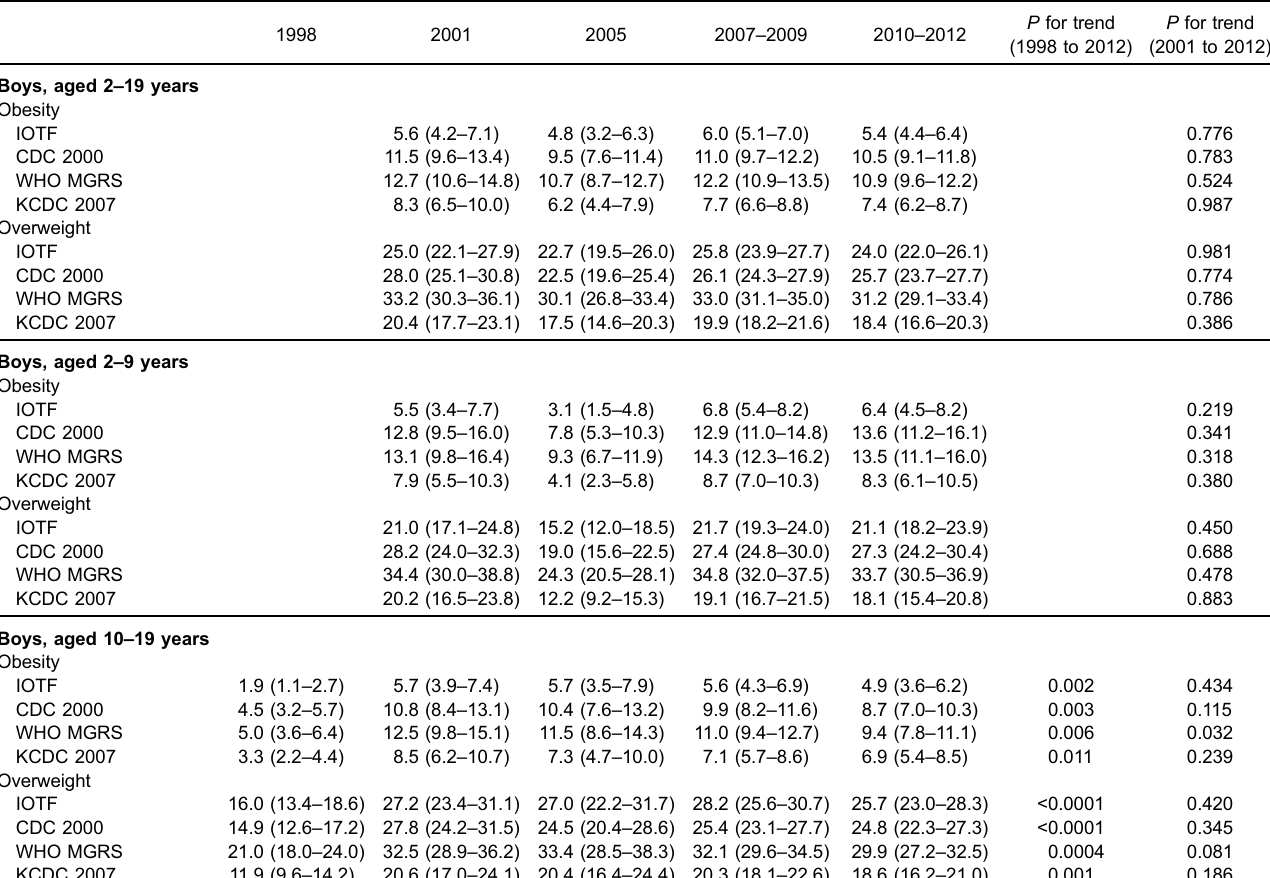
Table 3. Trends in age-standardized prevalence (95% con fi dence intervals) of overweight and obesity among South